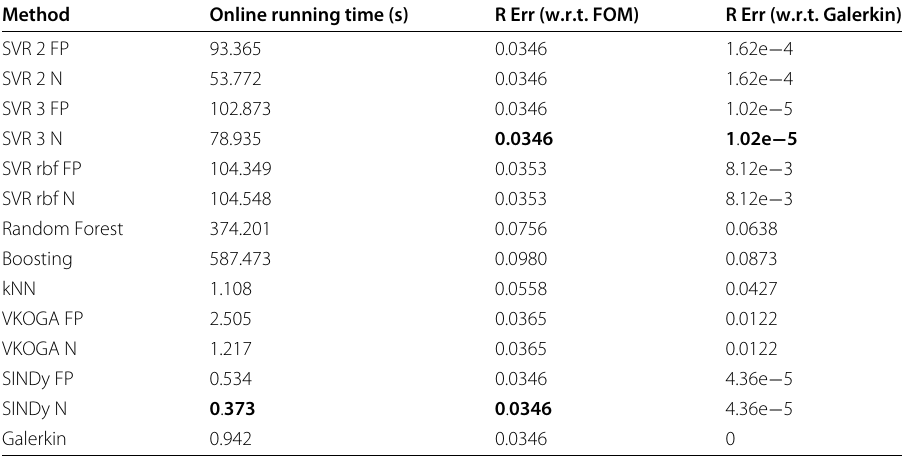
Table 1 Comparison of different machine learning methods using backward Euler methods for 1D inviscid Burgers’ equation: Newton’s method (N); fixed-point iteration (FP)